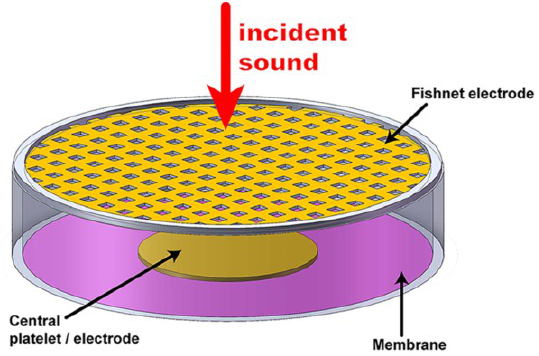
Figure 7. Schematic of the decorated membrane resonators (DMR) sample. Adapted with permission from [141], AIP Publishing, 2015.